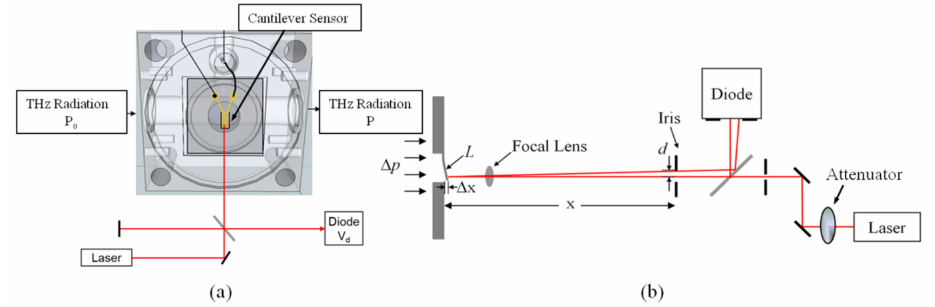
Figure 9. Schematic diagram (not to scale) showing ( a ) the custom, low-volume, photoacoustic (PA) test vacuum chamber with cantilever sensor position noted and ( b ) the PA optical measurement setup that was used to collect spectral